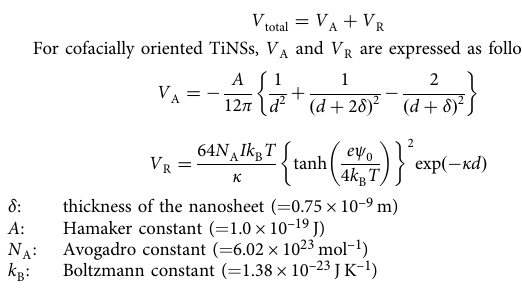
scopic visible/near infrared (Vis/NIR) spectrometer composed of a Nikon model Eclipse LV100POL optical polarizing microscope equipped with an Ocean Optics model USB4000 spectrometer. For retardation measurement, an Olympus model U-CBE Berek compensator and an Olympus 43IF550W45 interference green fi lter (550nm) was used. For DLS measurement, a Hamamatsu model H7421-40 photon counting head was used for detecting the scattered light at various scattering angles and an LS Instruments model LSI correlator for processing the signal pulses to obtain autocorrelation functions. For analysis of POM and CLSM images, the software ImageJ (http://imagej.nih.gov/ij/) was used. An aqueous dispersions of unilamellar titanate(IV) nanosheets (TiNSs; Supplementary Fig. 1) was prepared according to the literature method 35 . Water was obtained from a Millipore model Milli-Q integral water puri fi cation system. Fluorescently labeled polymer micro- particles (micromer ® -redF; diameter = 5, 10, and 20µm; CO 2 H and NH 2 modi fi ed and unmodi fi ed) were purchased (Micromod Partikeltechnologie GmbH) and used after deionization.